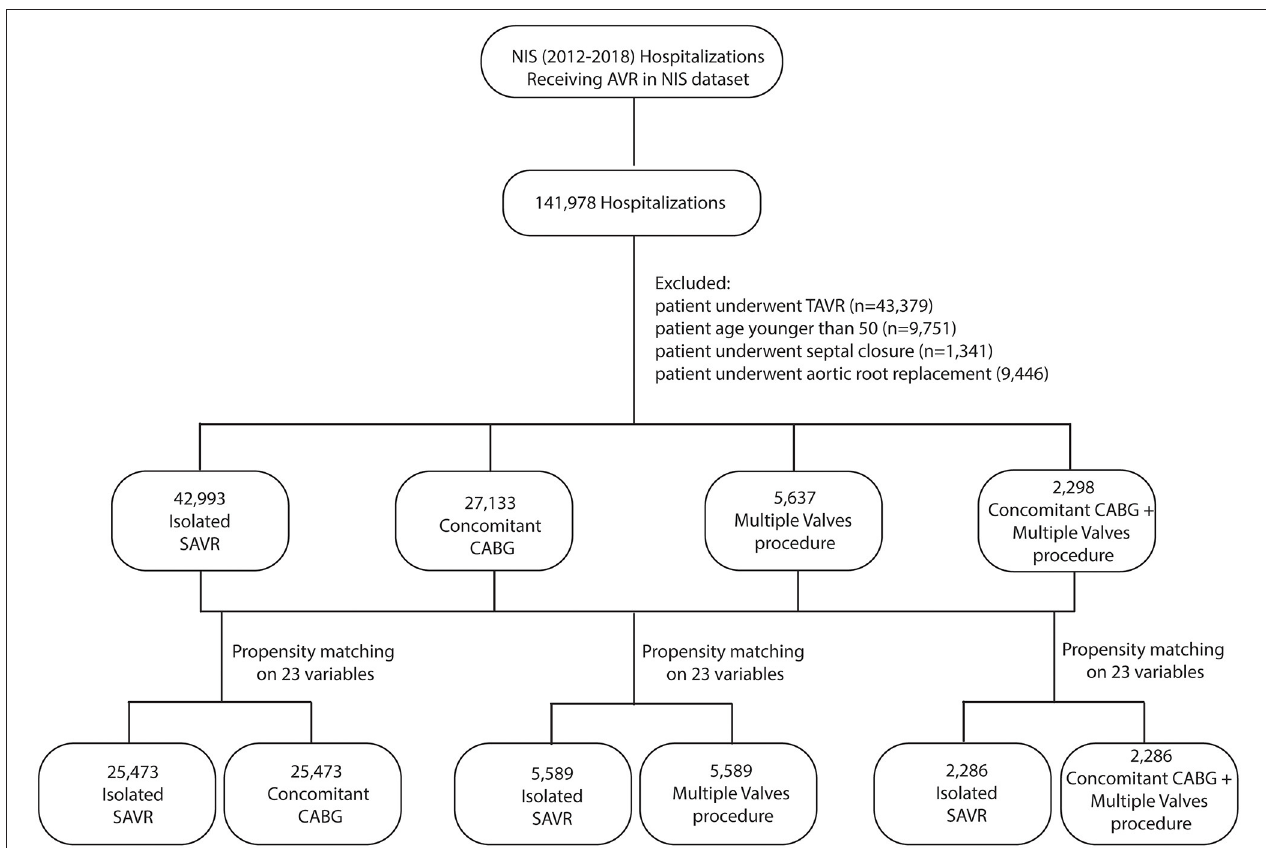
FIGURE 1 | Study flow chart. NIS, national inpatient sample; CABG, coronary artery bypass grafting; SAVR, surgical aortic valve replacement; TAVR, transcatheter aortic valve